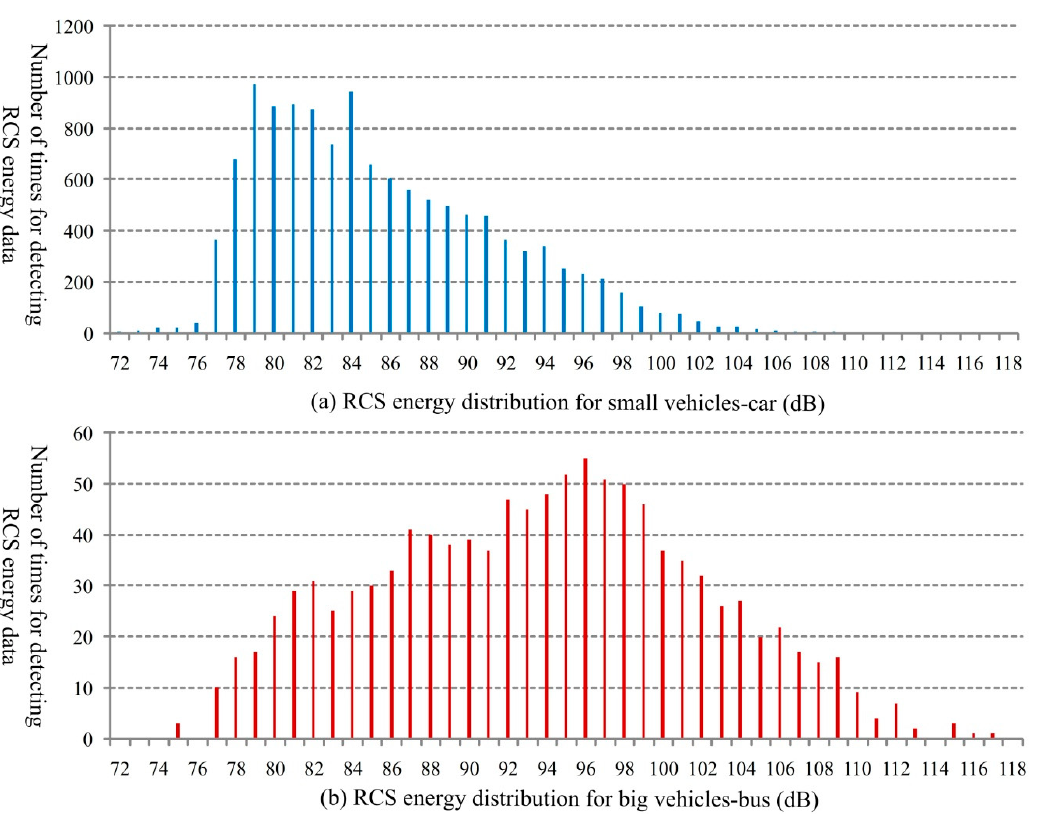
Figure 10. Distribution of the number of times for RCS energy measurement for different types of vehicles.